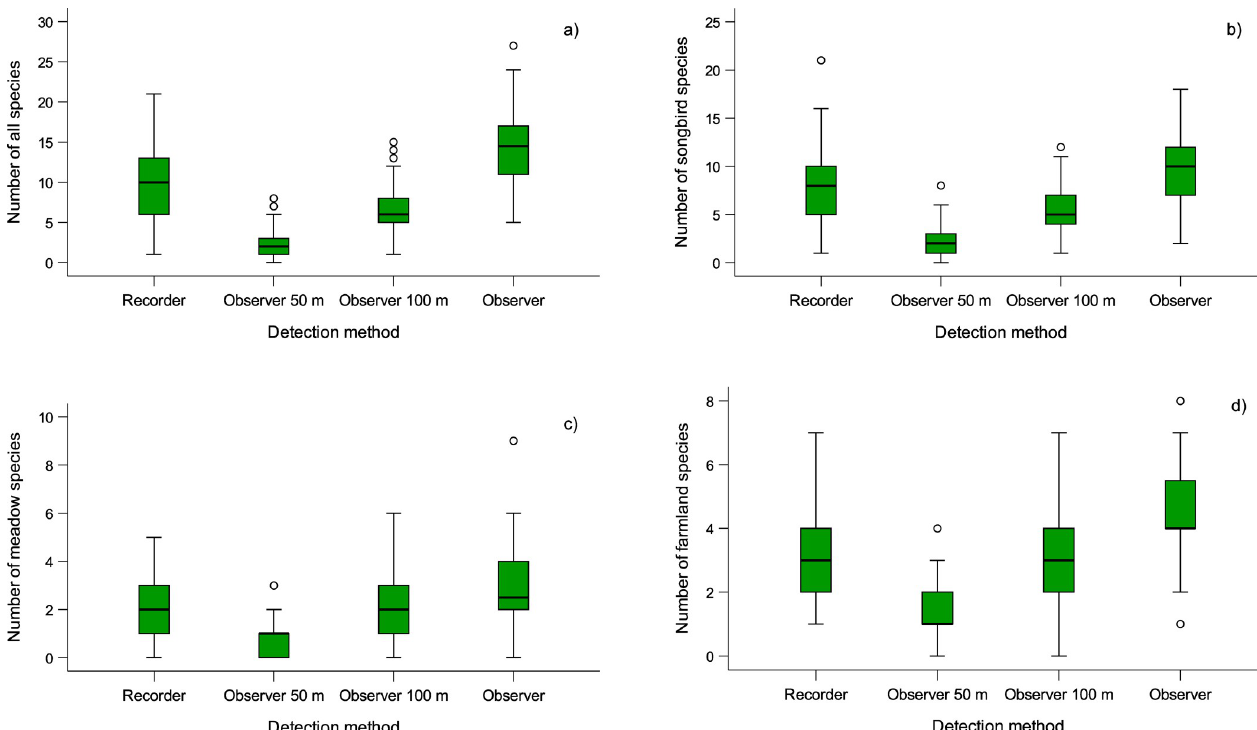
Fig 2. Number of detected bird species by various detection methods. Graphs show (a) all bird species, (b) songbird species, (c) farmland bird species and (d) meadow bird species by four detection methods: (1) recorder, (2) observer surveying birds within 50 m radius, (3) observer surveying birds within 100 m radius, and (4) observer surveying birds in unlimited radius. Boxplots show the median, interquartile range, and outliers.